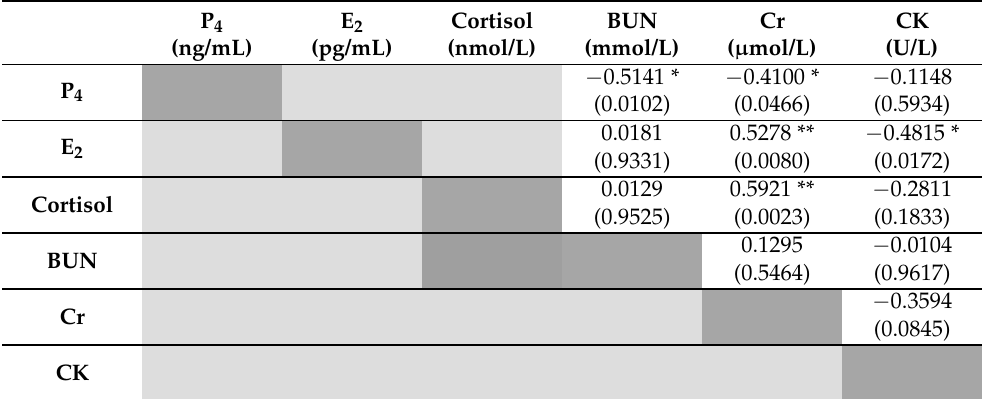
Table 9. Pearson correlation coefficient between steroids hormones, BUN, Cr and CK in non-pregnant non-lactating ( n = 14), non-pregnant lactating ( n = 8) and pregnant ( n = 38)